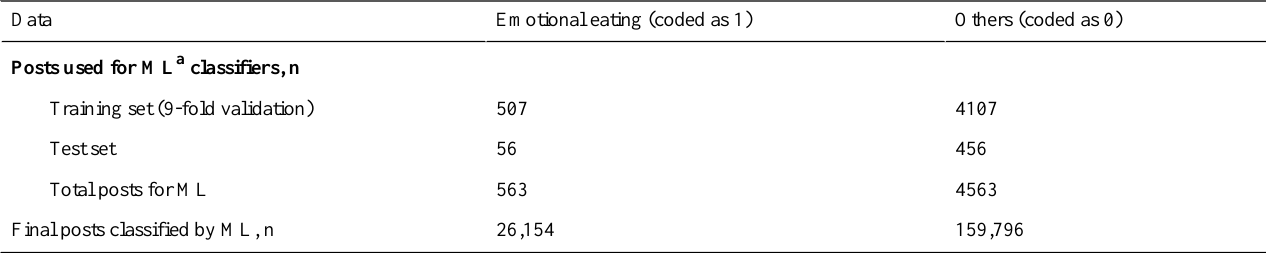
Others (coded as 0)Emotional eating (coded as 1)Data